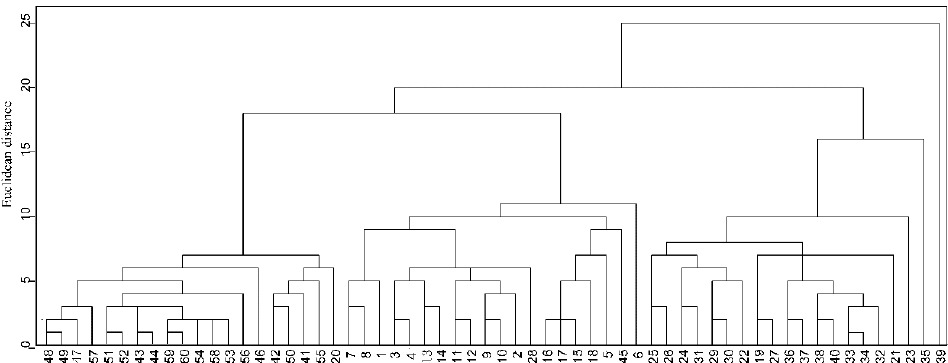
Figure 3. Systematic clustering results for P. clarkii muscle samples from three different regions.